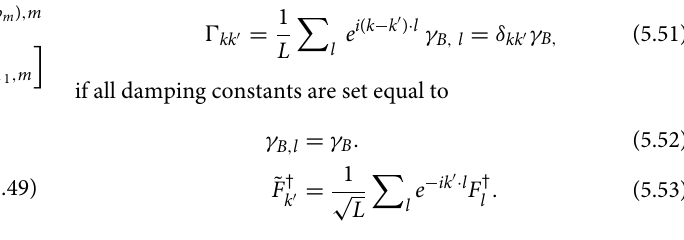
, gp 3 s † gp 2 = = 0 . 0005 . =